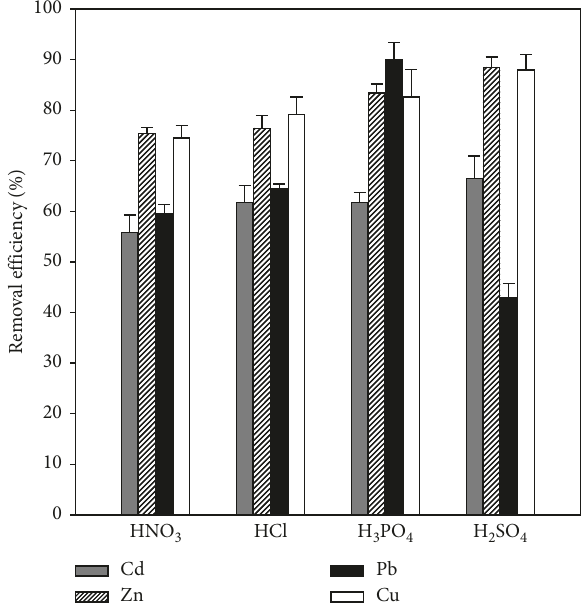
Figure 1: Removal efficiency of heavy metals by using various acid reagents.